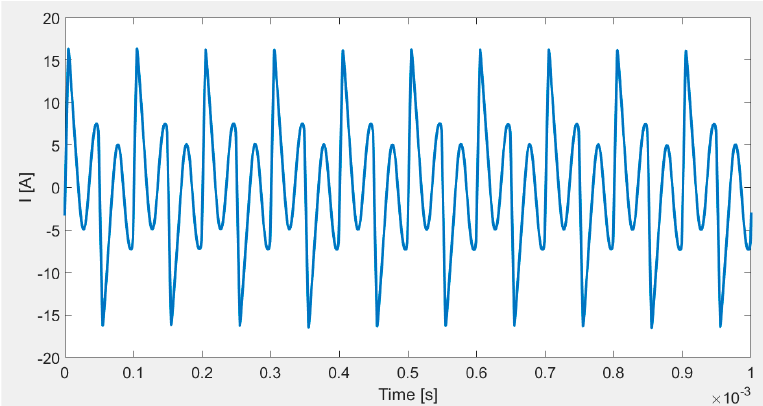
Figure 7. Current in the primary winding of the transformer with a high value of parasitic capacitance in the secondary winding of the converter in phase-shifted mode (simulation results).